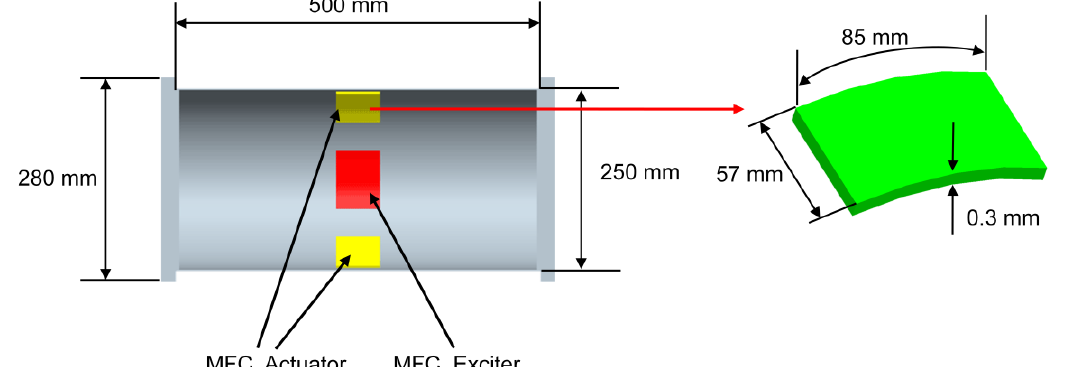
Figure 3. Geometry of the end-capped cylindrical shell structure with surface bonded MFC